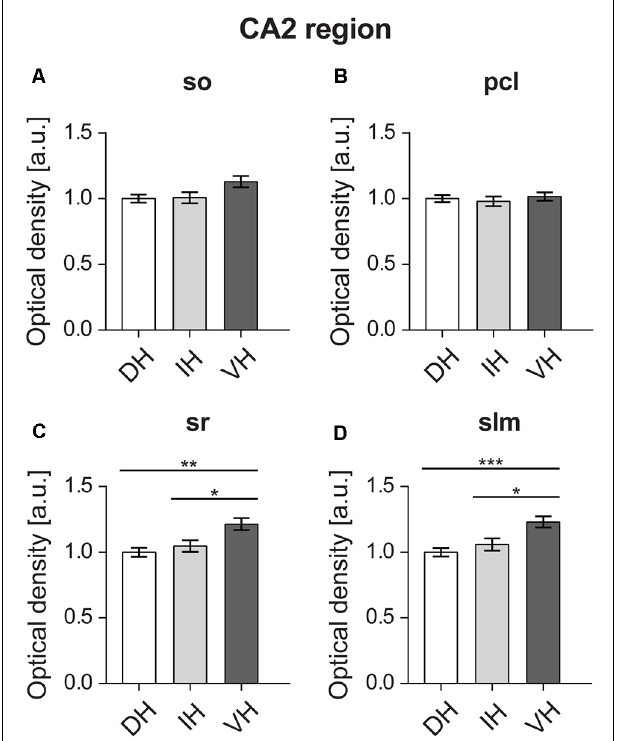
FIGURE 5 | In the CA2 region, D2R expression is highest in the ventral apical dendrites. The D2R is equally expressed in the Stratum oriens (so) (A) and pyramidal cell layer (pcl) (B) across the longitudinal axis of the CA2 region. Receptor protein expression is highest in the ventral Stratum radiatum (sr) (C) and Stratum lacunosum-moleculare (slm) (D) as opposed to dorso-intermediate CA2. Values expressed in arbitrary units (a.u.). Error bars indicate SEM. ∗ p < 0.05, ∗∗ p < 0.01, ∗∗∗ p < 0.001. so, Stratum oriens; pcl, pyramidal cell layer; sr, Stratum radiatum; and slm, Stratum lacunosum-moleculare.